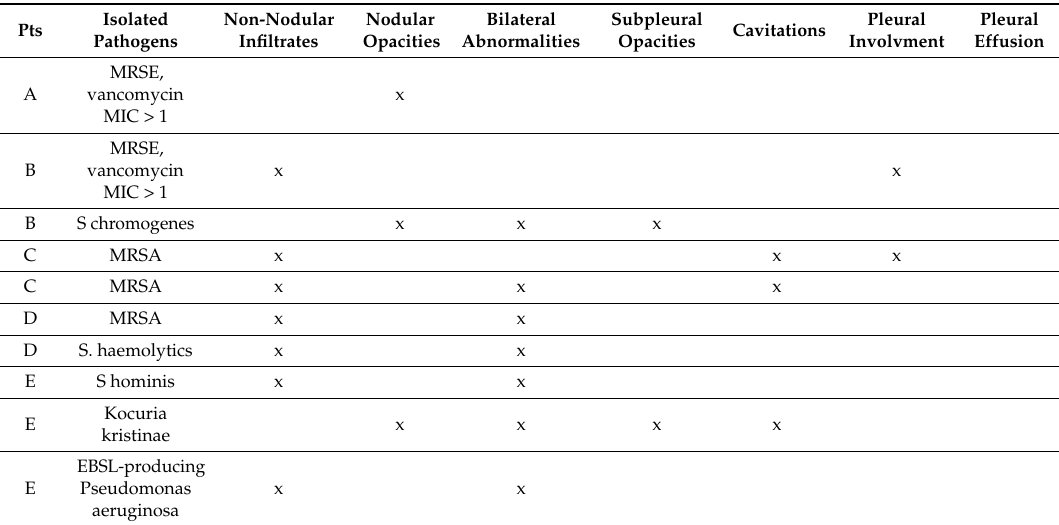
Table 3. CT findings of the 10 positive CT scans (10 episodes in five